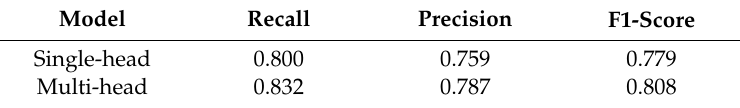
Table 4. Performance for di ff erent attention mechanisms in the dual pointer network decoder.